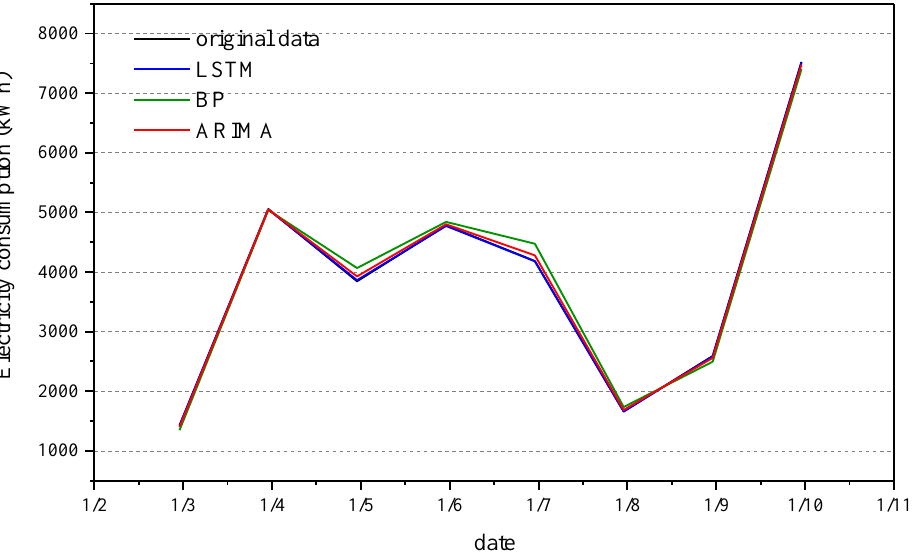
Figure 6. Different model daily air-conditioning electricity forecast results in 2017.